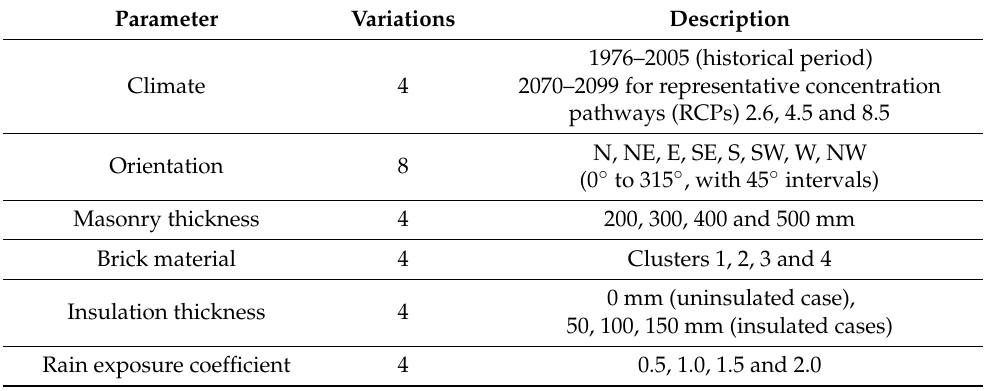
Table 1. Parameter variations in the sensitivity